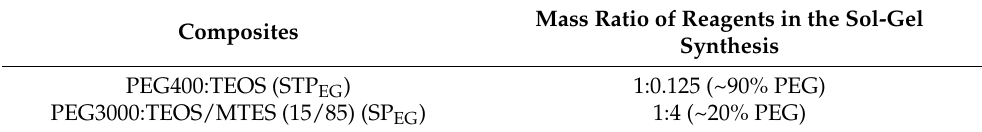
Table 1. Mass ratio of silica and polymer components in organosilica composites. Composites